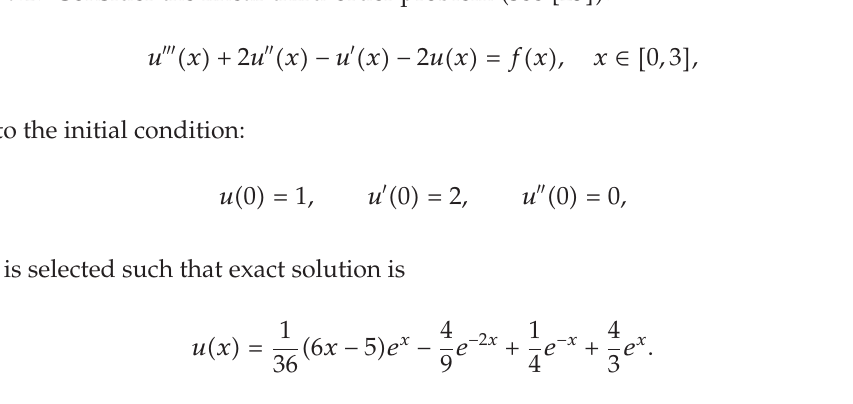
Table 1 list the maximum pointwise error of u − u N using the SJG method